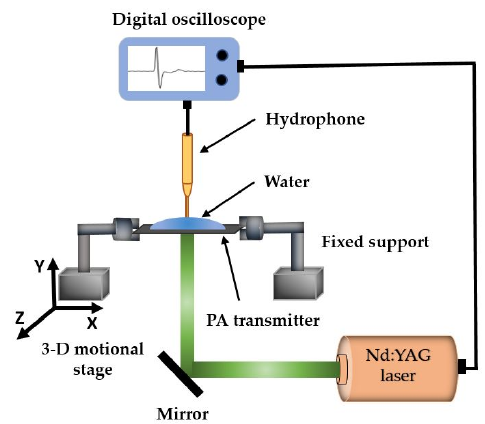
Figure 3. Experimental setup to determine PA output pressure amplitudes under an external strain applied to the free-standing transmitter not bound to a glass